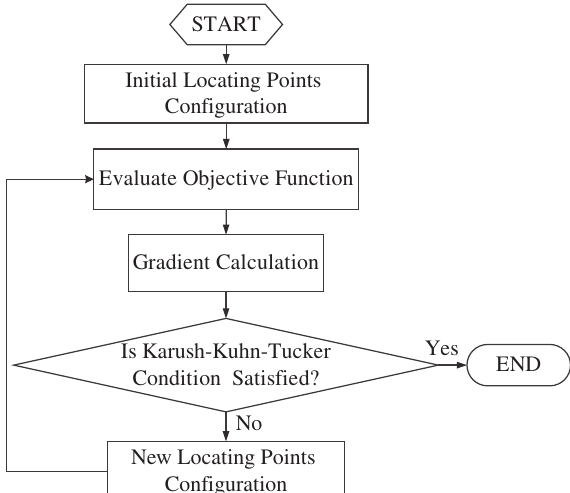
Figure 2. Flow chart of the optimization method.